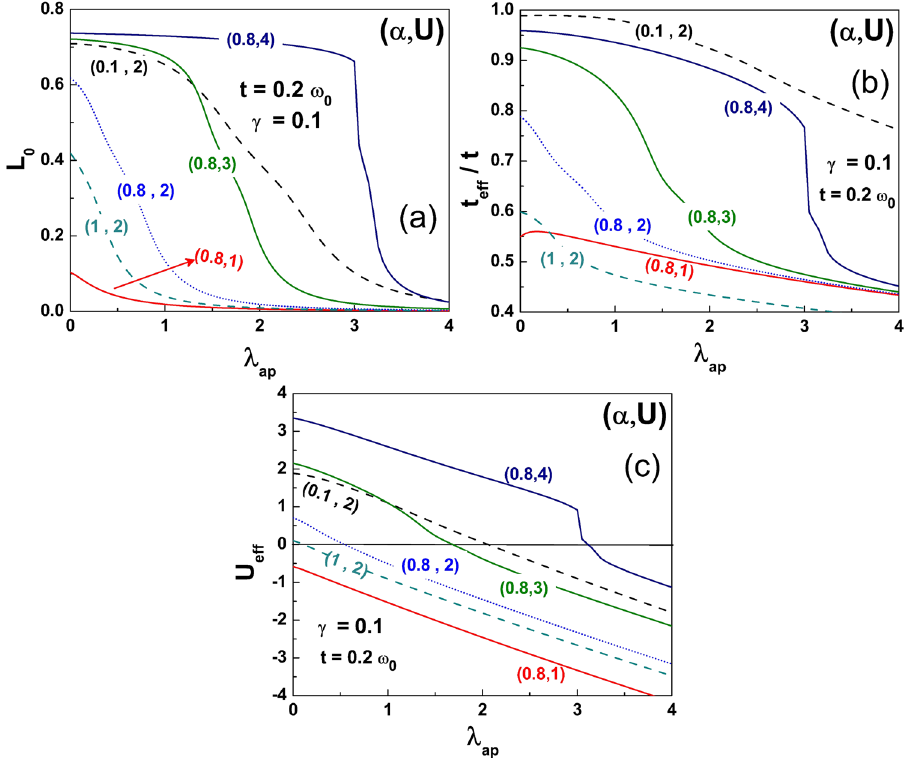
Figure 11. ( a ) Local spin moment L 0 as a function of the strength of the Gaussian anharmonicity λ ap . ( b ) Renormalized inter - site electron hopping term t eff /t as a function of λ ap . ( c ) Renormalized on-site e-e interaction strength as a function of λ ap